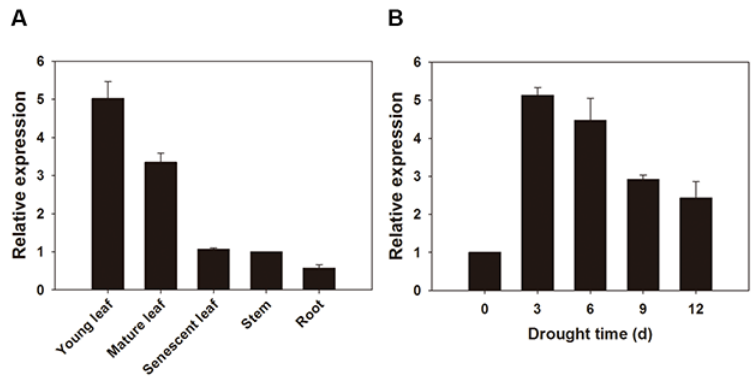
Fig. 2 Expression patterns of PdEPF3 . ( A ) Tissue-specific expression pattern of PdEPF3 in poplar. Young leaf – the first 1–3 leaves from the shoot apex; mature leaf – a fully expanded leaf; senescent leaf – lower most two to three leaves above the root system. The level of the PdEPF3 transcript in the stem was set as 1. ( B ) Expression of PdEPF3 in response to drought in poplar. Data represent means ± SE ( n =